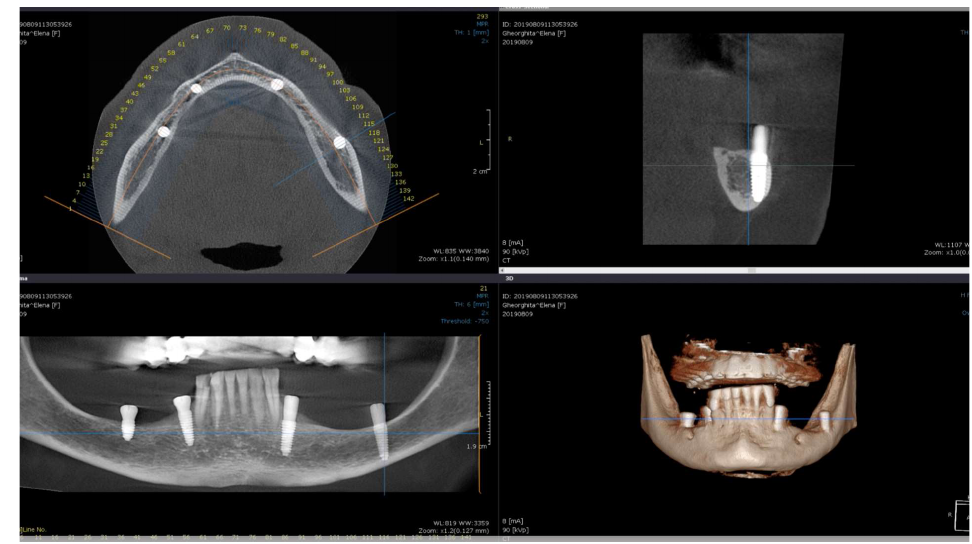
Figure 1. Postoperative CBCT of patient no. 6: ( Upper left )—axial view of the mandible; ( upper right )—sagittal left view of the buccally tilted implant (37); ( lower left )—coronal view of the mandible; ( lower right )—3D view of the mandible.